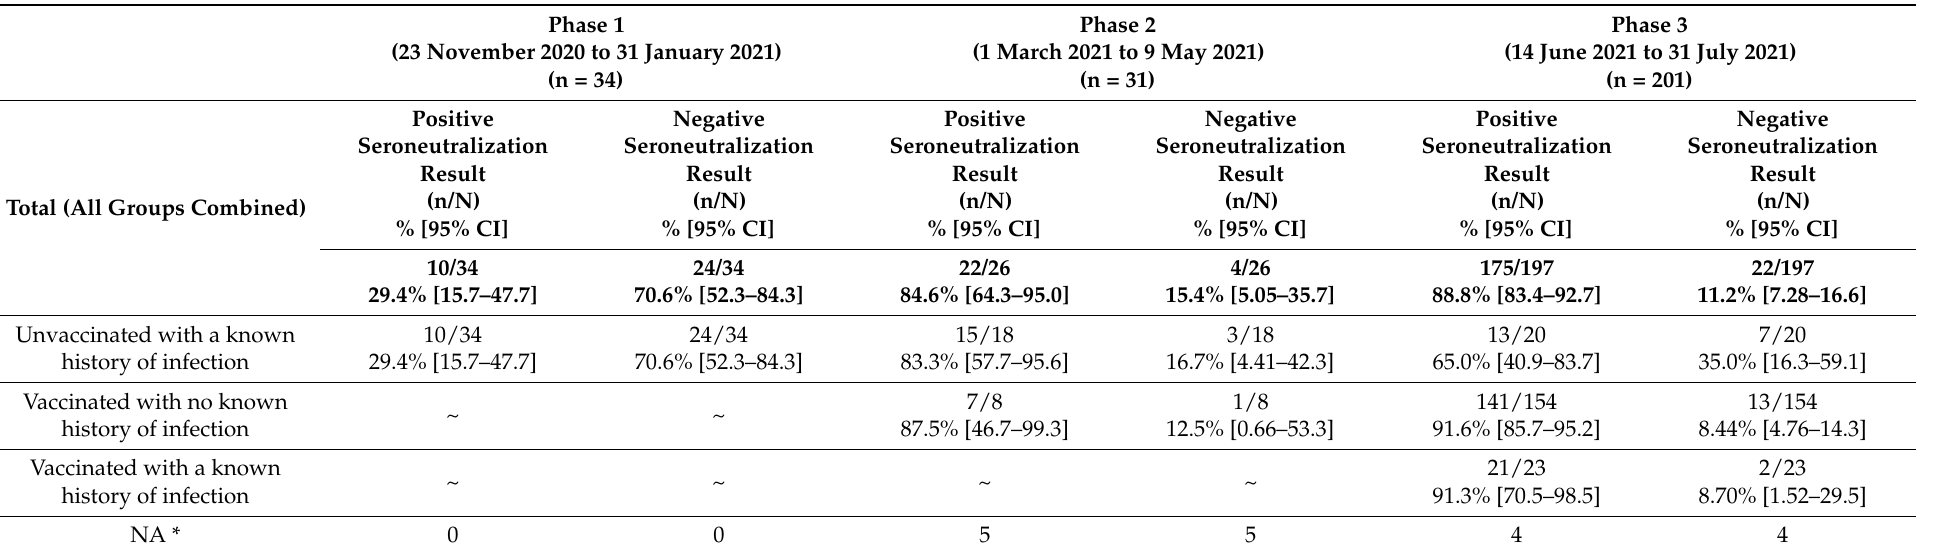
Table 5. Seroneutralization results of the participants according to their immune